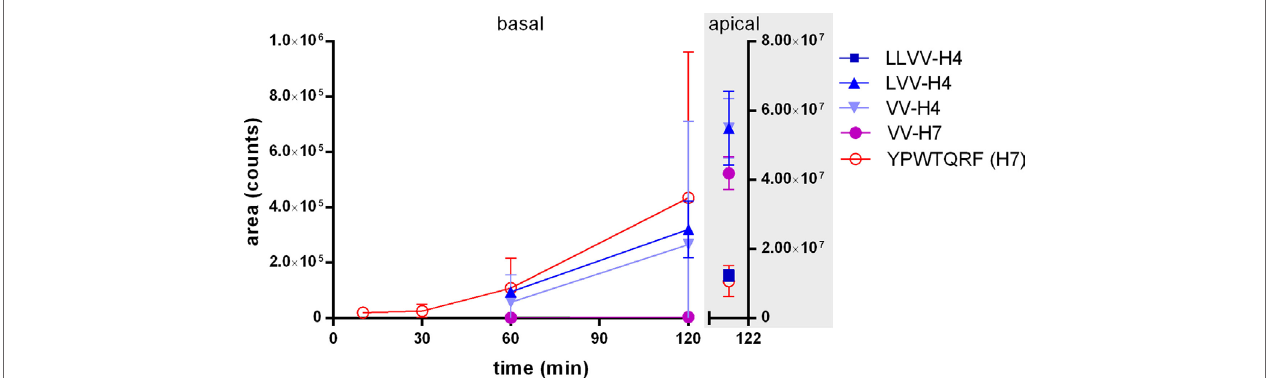
FigUre 1 | Appearance kinetics of the five hemorphins intact in the basal side of Caco-2 monolayer as an intestinal barrier (IB) passage model. The passage of the five hemorphins was tested in the Caco-2-transwell model of the IB. Each peptide was separately applied at 5 mM in the apical chamber of a transwell and the appearance of the intact peptide was monitored by LC-MS/MS with multiple reaction monitoring in the basal chamber at five time points. The graph also shows the remaining intact peptides in the apical chamber after 2 h incubation. Data are expressed as mean ± SD ( n =